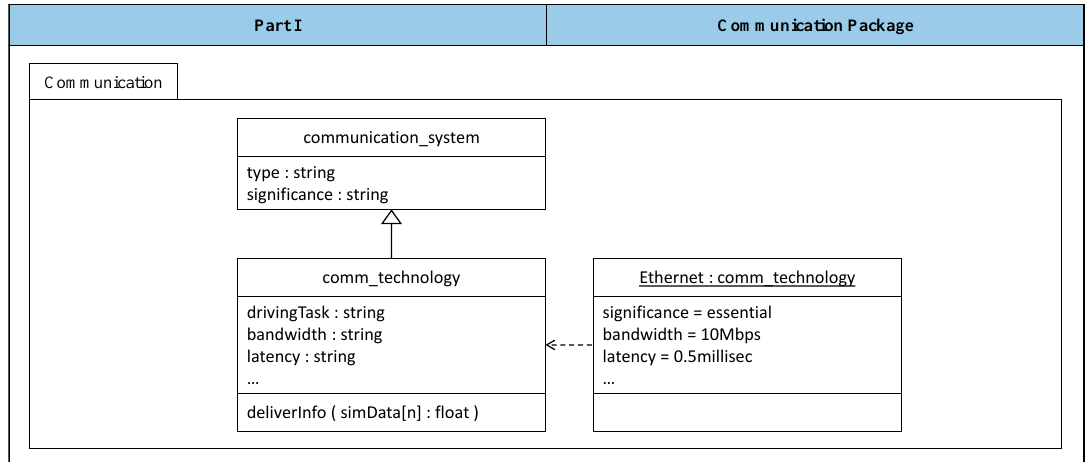
38 of 50 Figure 11. UML (The unified modeling language) class diagram of the selected simulation system components—package 1. The simulation package includes a main class named simulation_system. Two classes inherit the